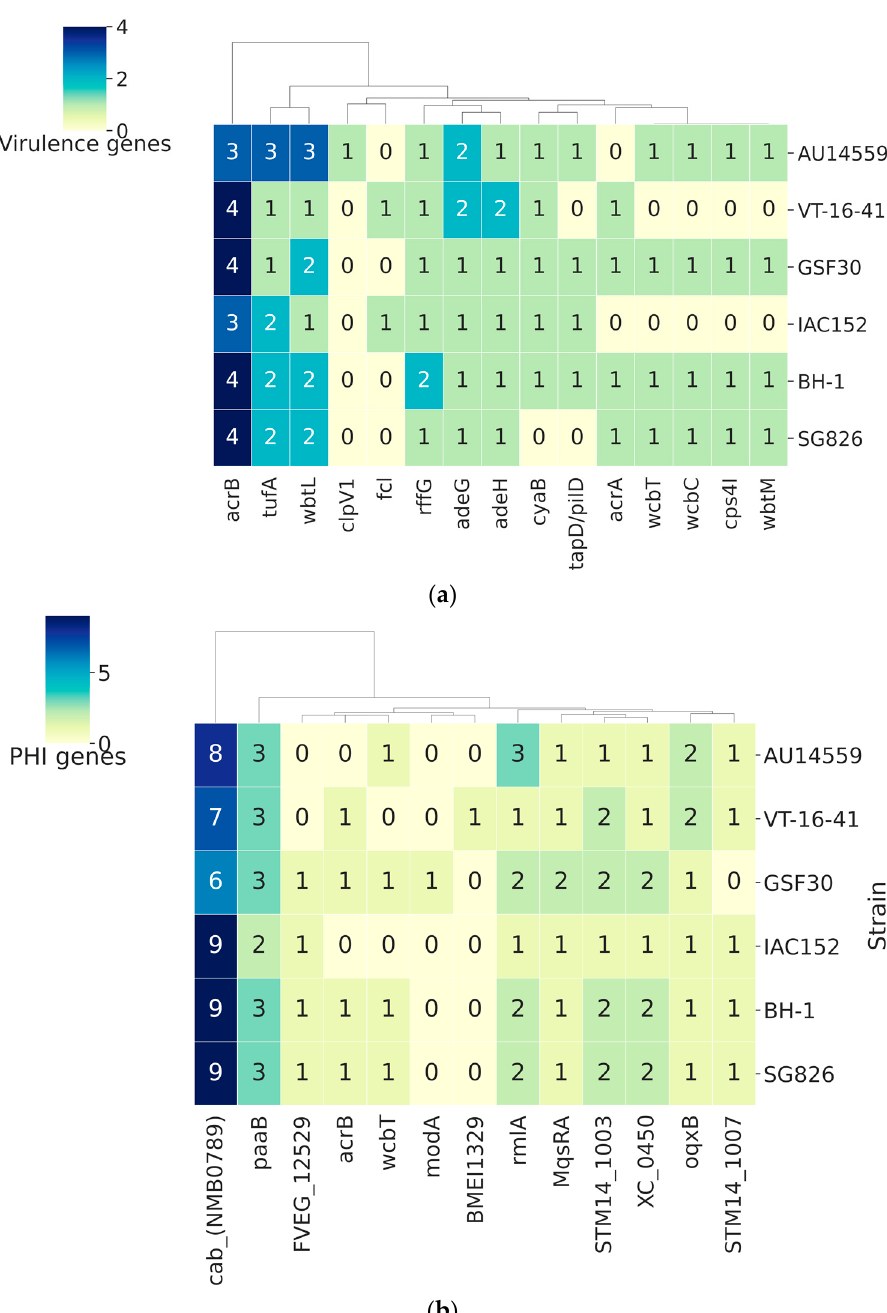
Figure 5. Interaction gene clustermaps: ( a ) virulence and ( b ) host–pathogen interaction factors found in H. frisingense strains. The identification was performed using BLASTP to compare representatives of the clusters generated by Panaroo with the proteins in the PHI-base and VFDB databases. Only sequences that displayed a minimum of 80% coverage and 50% identity when aligned with the proteins represented in the databases were considered.